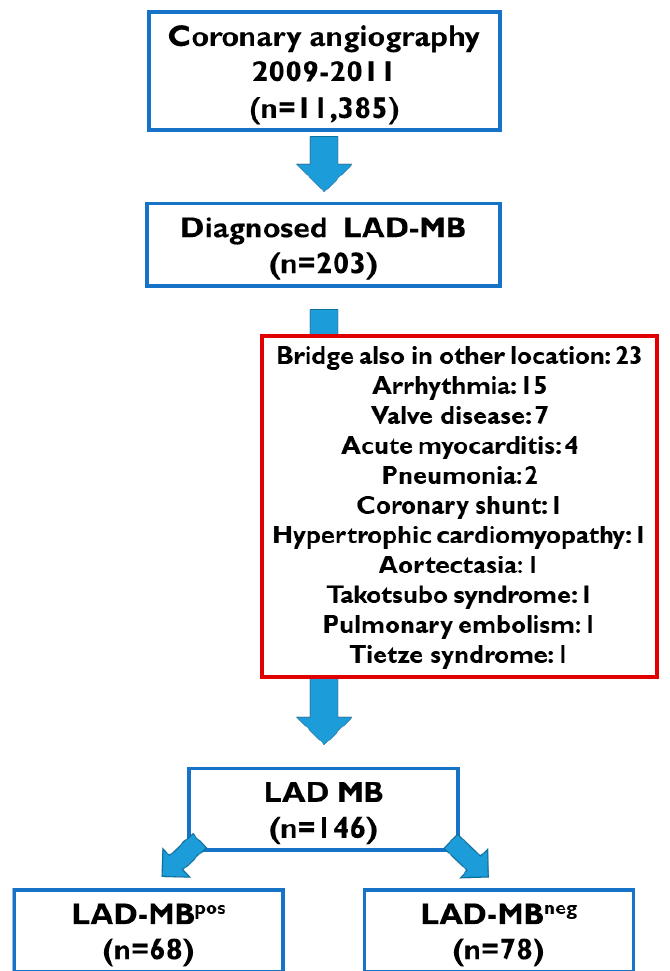
Figure 1. The design of the study and the selection of patients. LAD-MB: Myocardial bridge of left anterior descendent coronary artery; LAD-MB pos : Left anterior descendent myocardial bridge with another significant atherosclerotic coronary lesion group; LAD-MB neg : Left anterior descendent myocardial bridge without another significant atherosclerotic coronary lesion group.